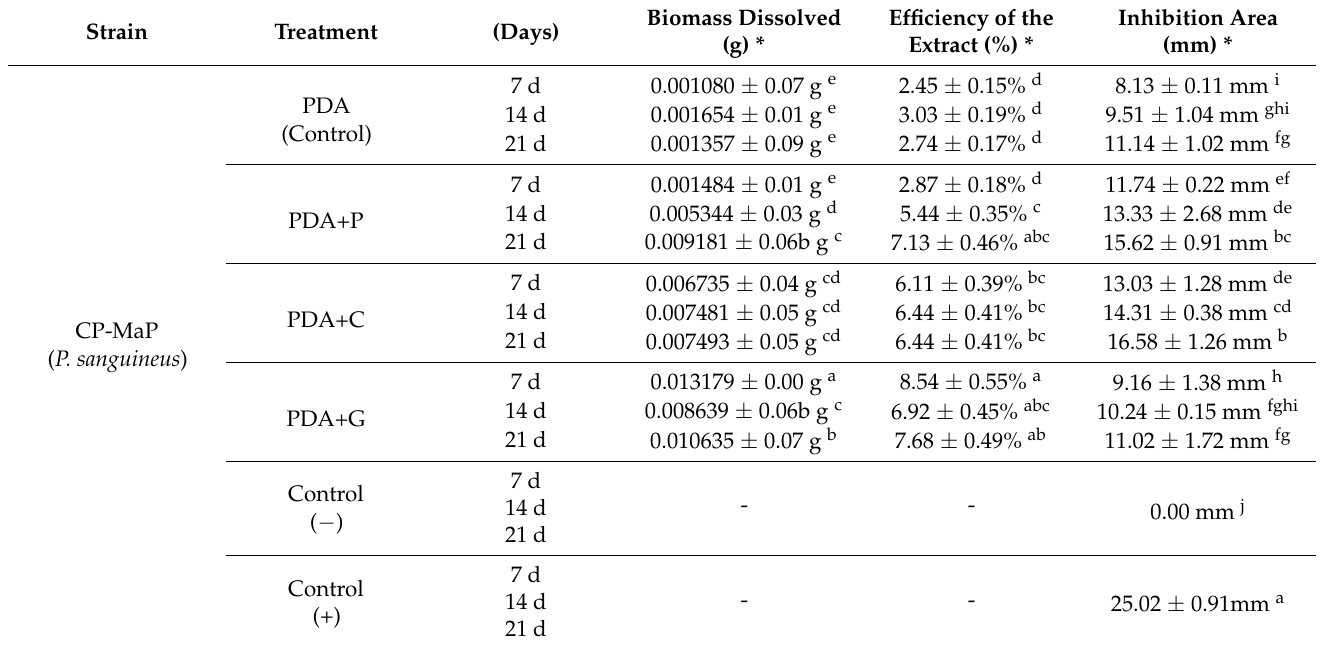
Table 2. Biomass dissolved, efficiency of the extract and zone of inhibition of effect of cinnabarin on X. campestris pv. campestris